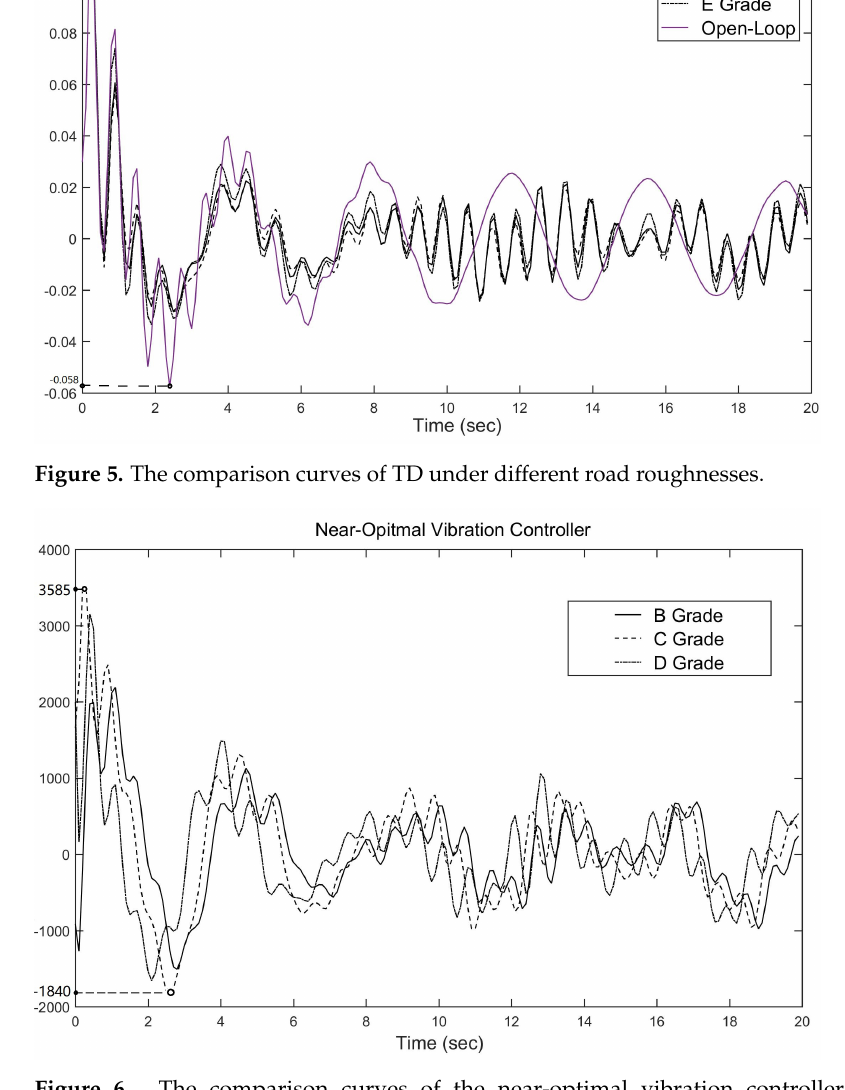
Figure 6. The comparison curves of the near-optimal vibration controller under different road